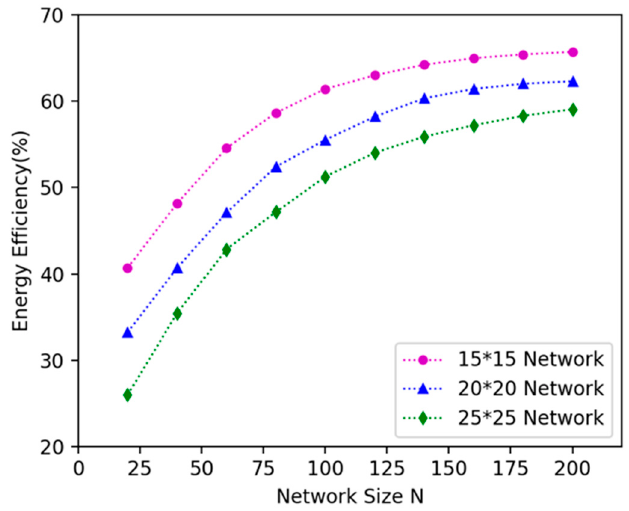
Figure 12. The influence of network size N on energy efficiency of the DCV.